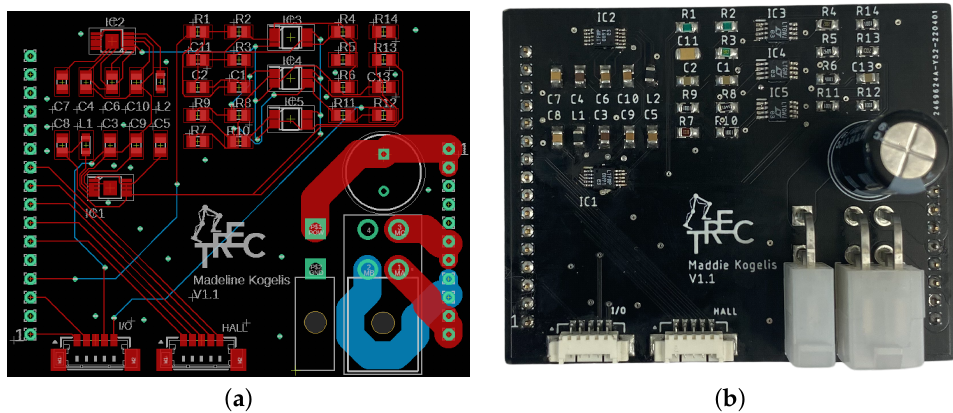
Figure 9. The motor shield is designed to handle power distribution, sensor and motor command routing, and motor phase powering. ( a ) Layout of motor shield PCB. ( b ) Physical build of the motor shield.